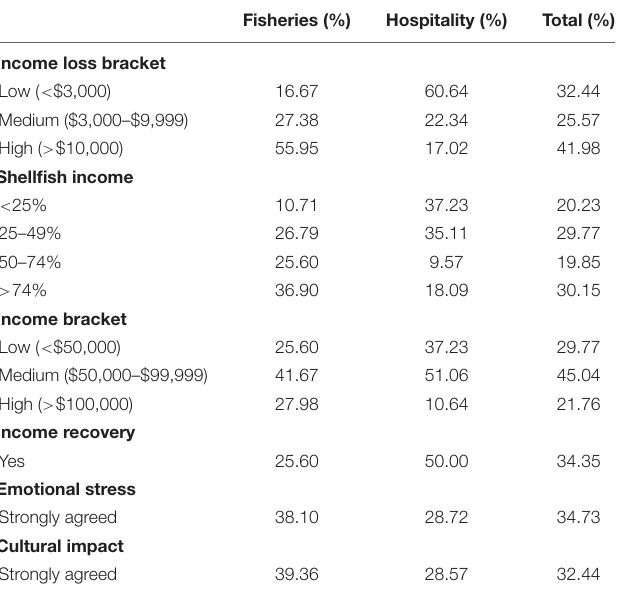
TABLE 3 | Summary of socioeconomic variables by employment industry.